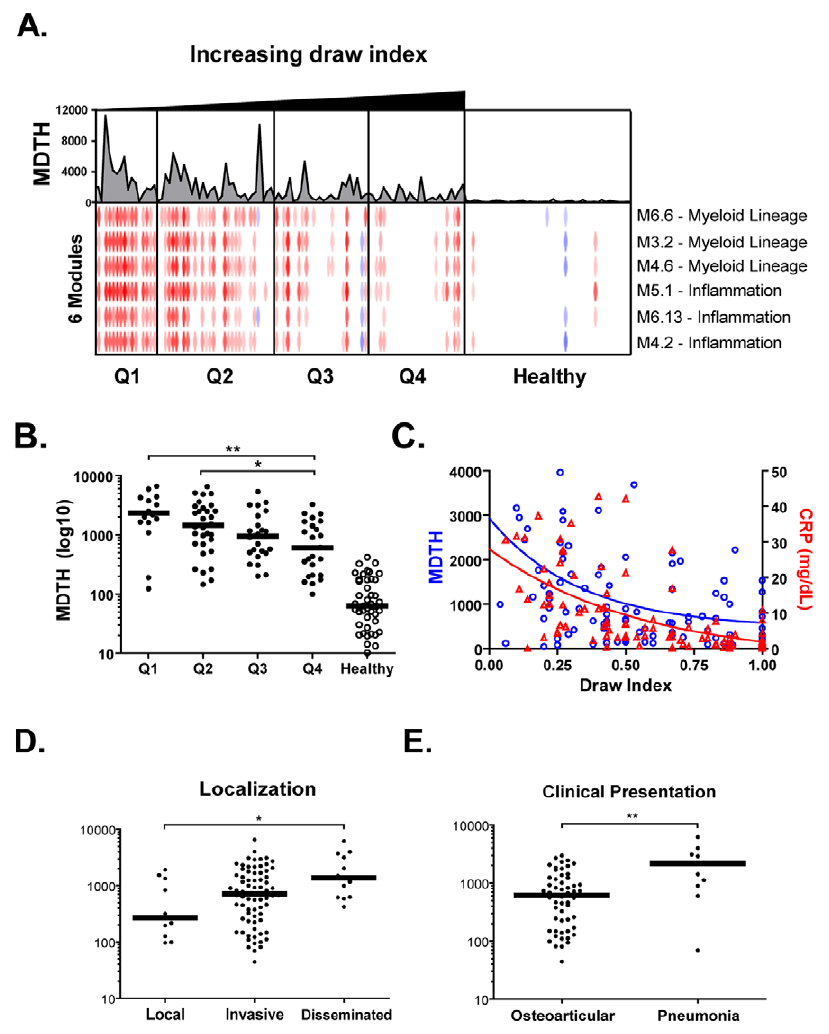
Figure 4. Patient signature varies with blood draw index, dissemination and clinical presentation. A. Patients were organized in four quarters Q1 through Q4 based on blood draw index (ratio draw day/hospitalization duration). A low draw index signifies proximity to hospital admission while a high draw index signifies proximity to discharge. Transcripts differently expressed between the four draw index quarters were selected by non-parametric ANOVA (Kruskal-Wallis, p , 0.01, Benjamini-Hochberg false discovery rate) and represented as a heatmap (red, yellow, blue). The same statistical filter was applied at the module level (red, white, blue heatmap below). Individual MDTH was represented above as a line chart. B. Column scatter plot of individual MDTH per blood draw index quartile. Horizontal bars represent group median. Non-parametric ANOVA (Kruskal-Wallis) with Dunn’s post-hoc test was applied. C. Non-linear regression model (one-phase decay) of MDTH (left Y-axis) and CRP (right Y-axis) as a function of blood draw index. D. Column scatter plot of individual MDTH per infection localization group. E. Column scatter plot of individual MDTH per clinical presentation group. Horizontal bars represent the median value for each group. Non-parametric ANOVA (Kruskal-Wallis) with Dunn’s post-hoc test was applied between patient